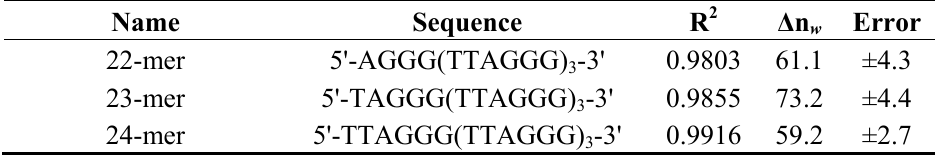
Table 2. The number of waters bound upon thermal denaturation of 5'